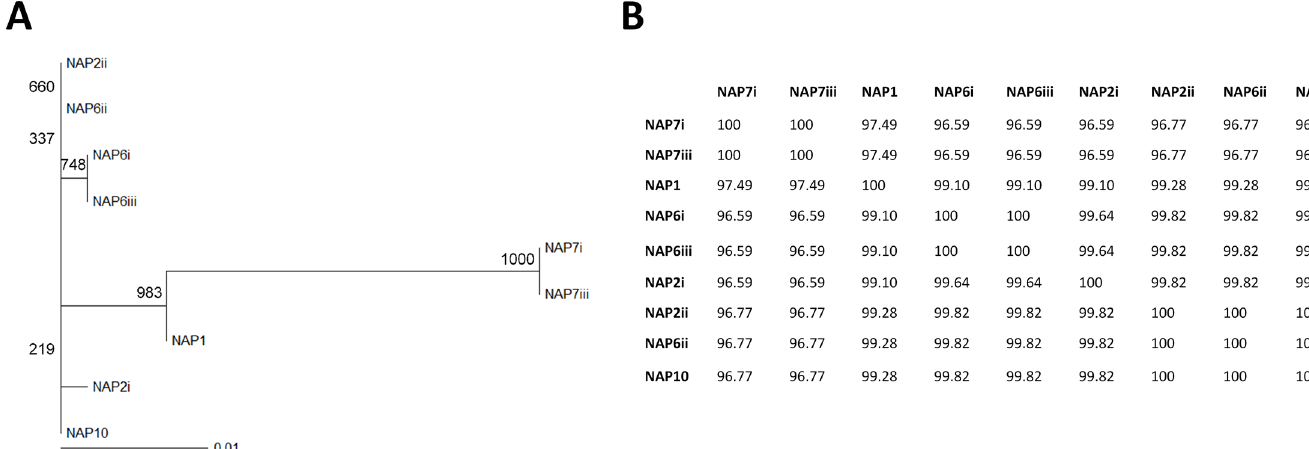
Fig 5. CspC sequences primarily cluster by PFGE type. A) Boot-strapped phylogenetic tree generated by UPGMA method. Boot-strap values are indicated at each node. B) Percent identity matrix for CspC sequences. Roman numerals indicate isotype number within each PFGE type. Legend: NAP = North American pulsed-field gel electrophoresis (PFGE)